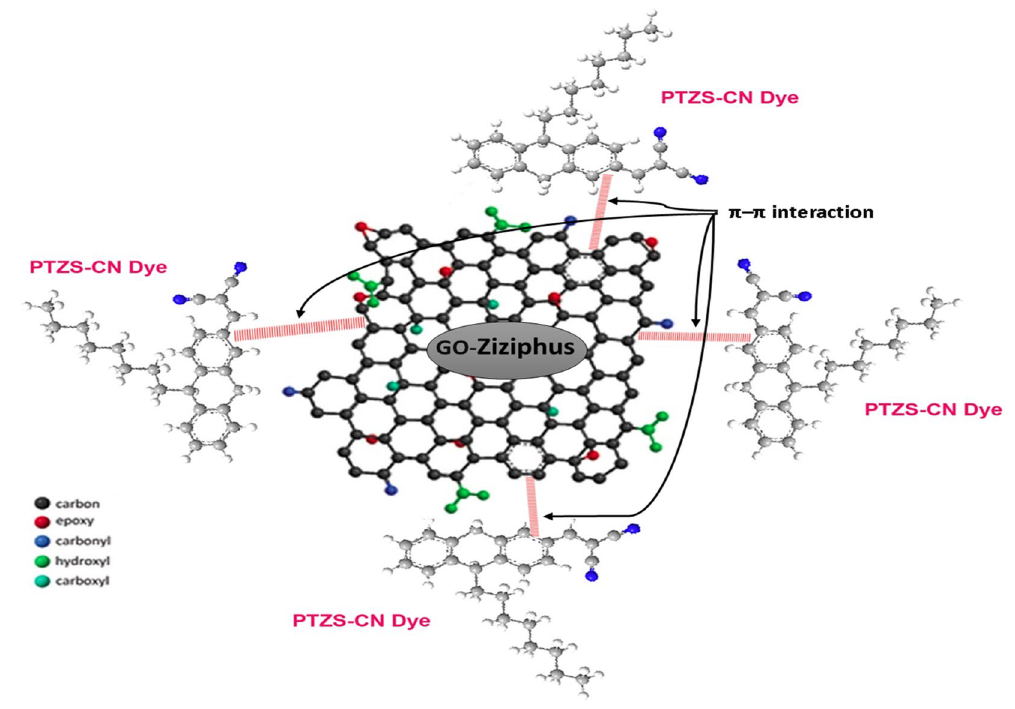
Figure 11. proposed mechanisms of PTZ-CN dye onto GO- Ziziphus